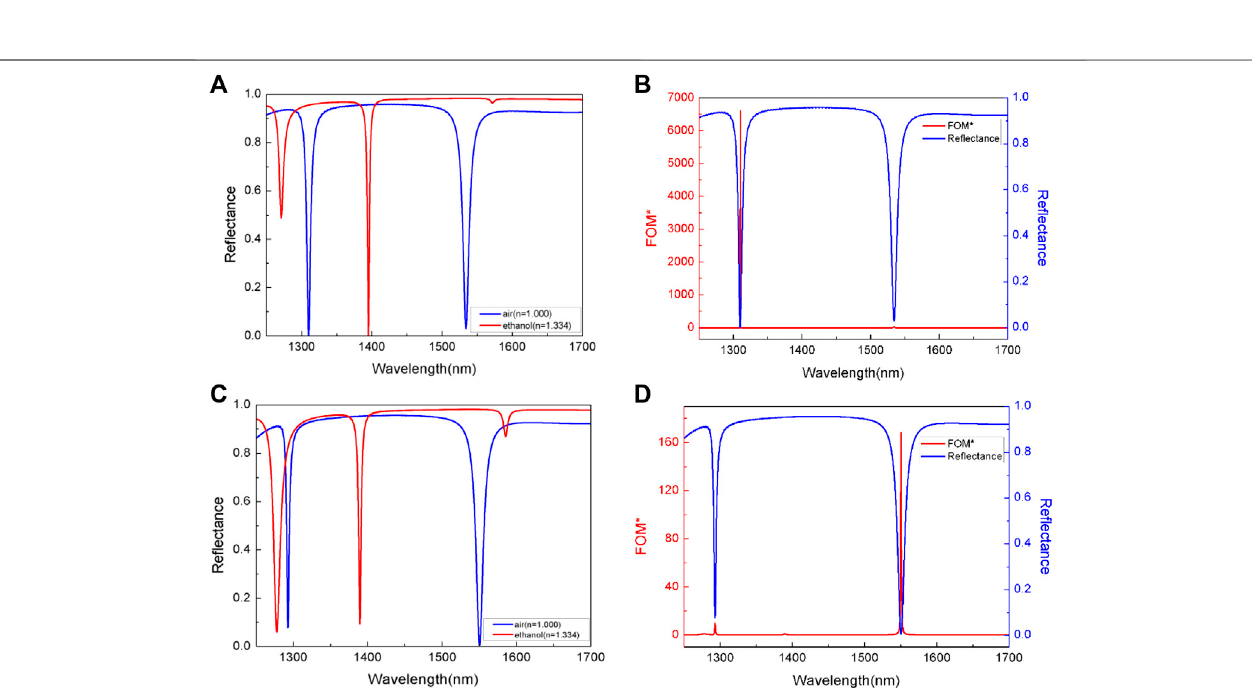
and Figure 9A , respectively. They are both red-shifted by increasing the refraction index from 1.334 to 1.364, and the